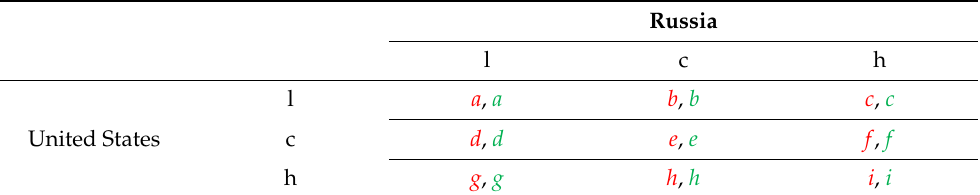
Table 7. Payoff matrix for Russia-U.S. subgame, unsanctioned Russia.